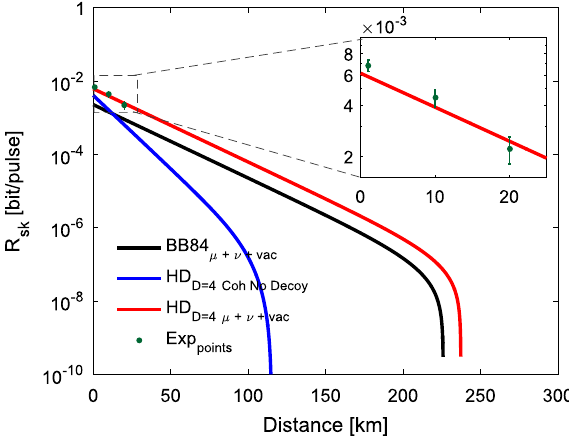
Fig. 5 Comparison between experimental data and theoretical simulation. We overlapped the experimental data with the expected theoretical rate as a function of the link distance. The parameters used are: p dark = 2 × 10 − 8 , η d = 0.1, α loss = 0.2 dB/km, u = 0.3, v = 0.15 for the decoy rates. Blue solid line is the rate without decoy state in case of WCP HD-QKD. Red and black solid lines are the simulated decoy state key rate for qubit or ququart